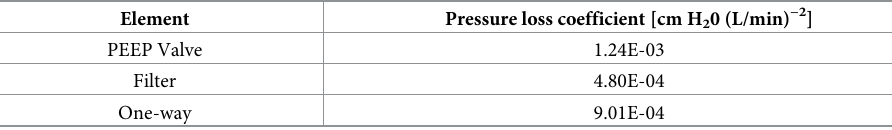
Table 2. Pressure loss coefficients for circuit